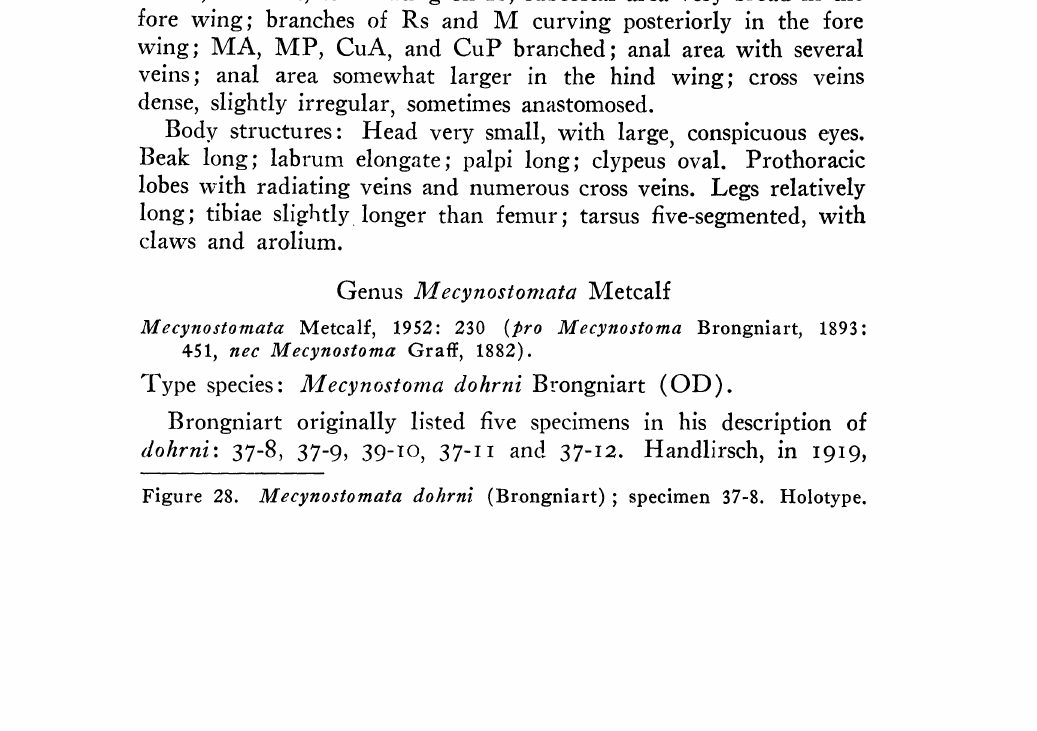
Figure 28. Mecynostomata dohrni (Brongniart); specimen 37-8.